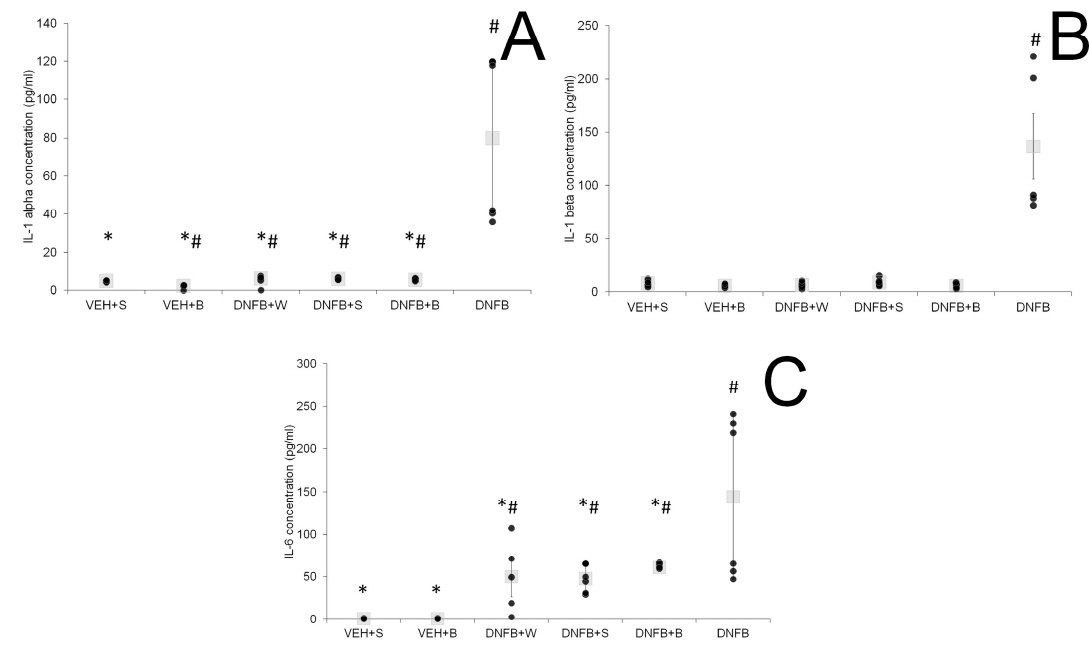
Figure 5. IL-1 α ( A ), IL-1 β ( B ) and IL-6 ( C ) levels in BALF. # p < 0.05 vs. VEH+S (Mann–Whitney U test); * p < 0.05 vs. DNFB (Mann–Whitney U test); means ± SE, n = 5–8; VEH+S, sham-sensitized saline-inhaled; VEH+B, sham-sensitized brine-inhaled; DNFB+W, sensitized pure water inhaled; DNFB+S, sensitized saline inhaled; DNFB+B, sensitized brine inhaled; DNFB, sensitized non-inhaled.